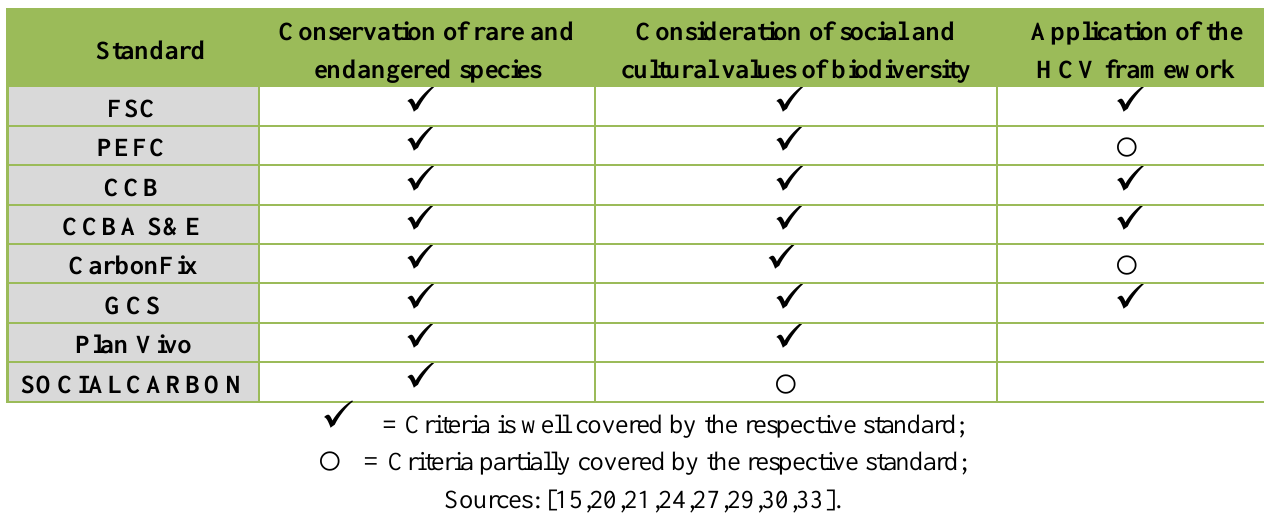
Table 4. Standard’s biodiversity conservation